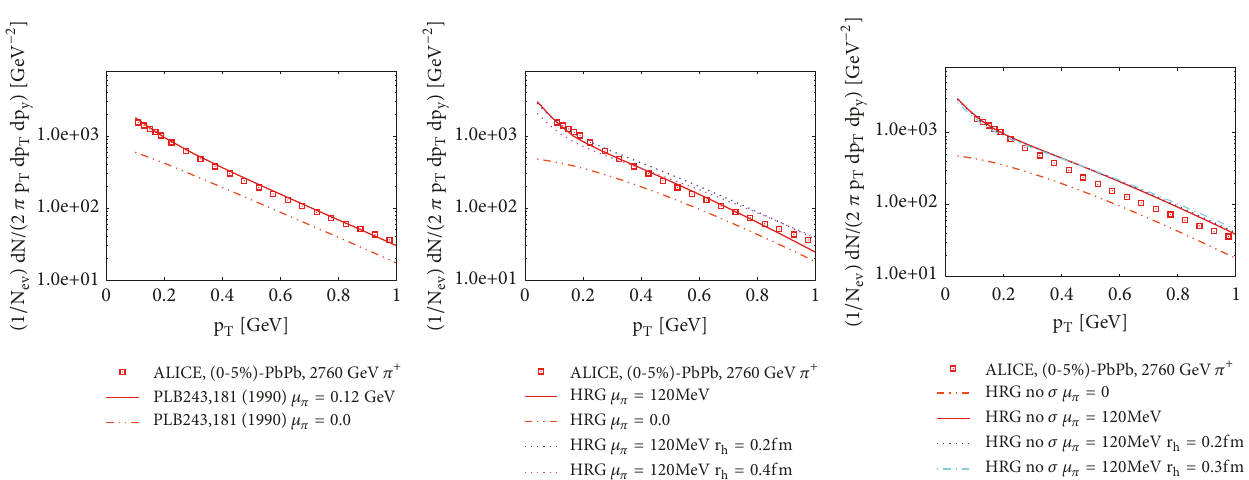
Figure 1: Number of positive pions per transverse momentum per rapidity is given dependent on the transverse momentum. The symbols refer to the ALICE measurements in the most central ( 0 − 5 %) Pb+Pb collisions at 2.67 TeV. The left-hand panel shows a comparison with (10) at vanishing 𝜇 𝜋 = 0 and finite 𝜇 𝜋 = 0.12 GeV [41]. In middle and right-hand panels, HRG calculations (10), with and without scalar 𝜎 states and excluded volume corrections are confronted to the experimental measurements, as